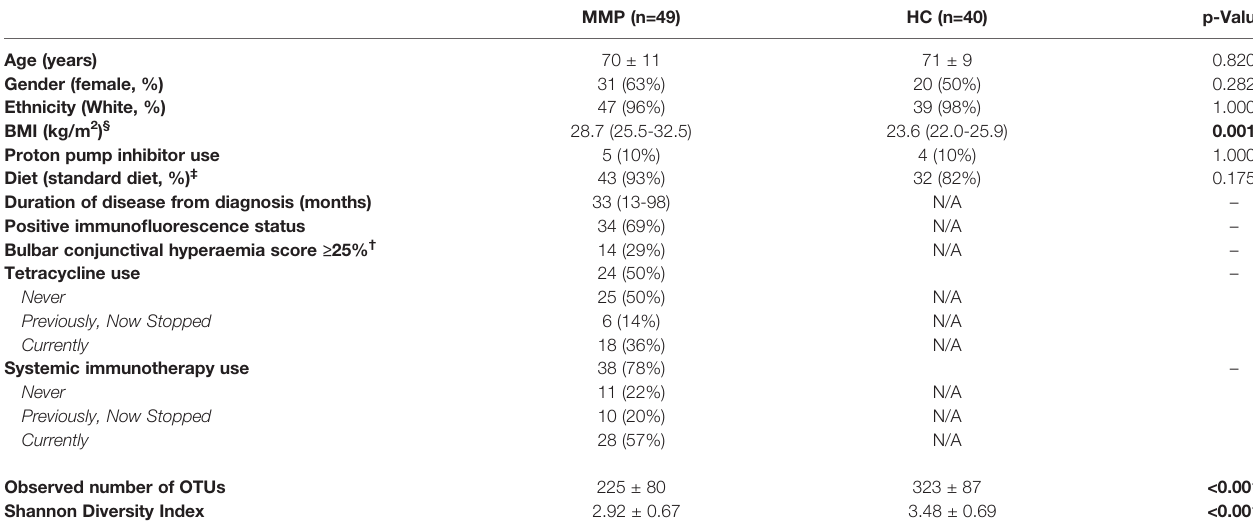
TABLE 1 | Demographics of